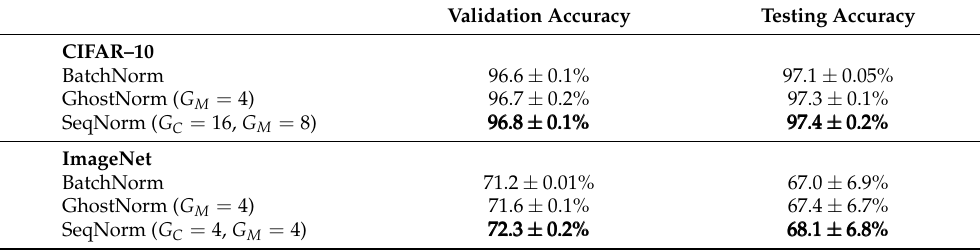
Table 2. Results on CIFAR-10 and ImageNet data sets. Both validation and testing performance results of CIFAR-10 are averaged over two different runs. For ImageNet, each model is evaluated on the conventional validation set, as well as on three newly released test sets